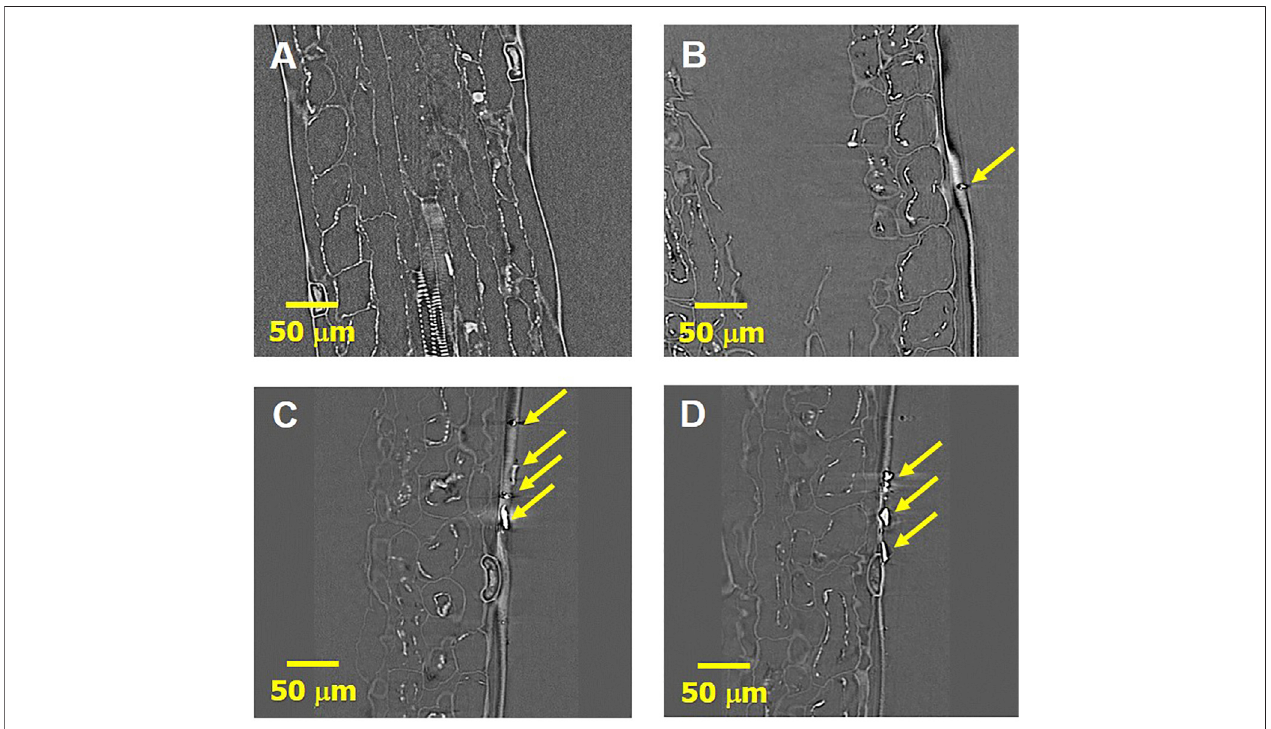
FIGURE 3 | Penetration of QD NPs via cuticlar cracks (physical barrier of foliar QD NP uptake). X-ray micro-CT images of the control (A) and QD NP-treated (B – D) garlic chive leaves for 21 days. 2D slices virtually extracted from the reconstructed 3D images. (A – D) Longitudinal section images (40 × ). (B – D) QD NPs translocate across the leaf epidermal barrier. Yellow arrowheads indicate QD